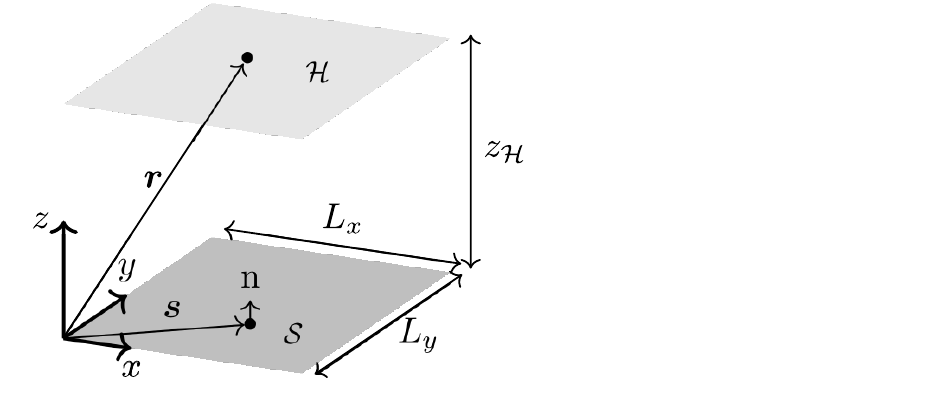
Figure 1. General setup for NAH. The vibrating surface defined according to a Cartesian reference system located at the bottom-left corner of soundfield is acquired by a microphone array placed in the hologram plane